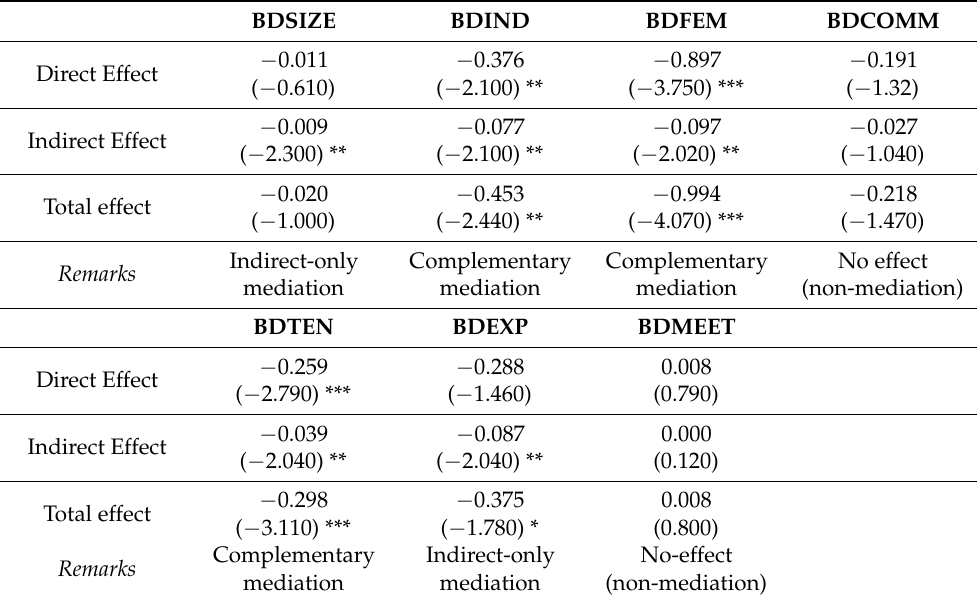
Table 7. Results of mediation between board attributes, KAMSCORE , and PRICE